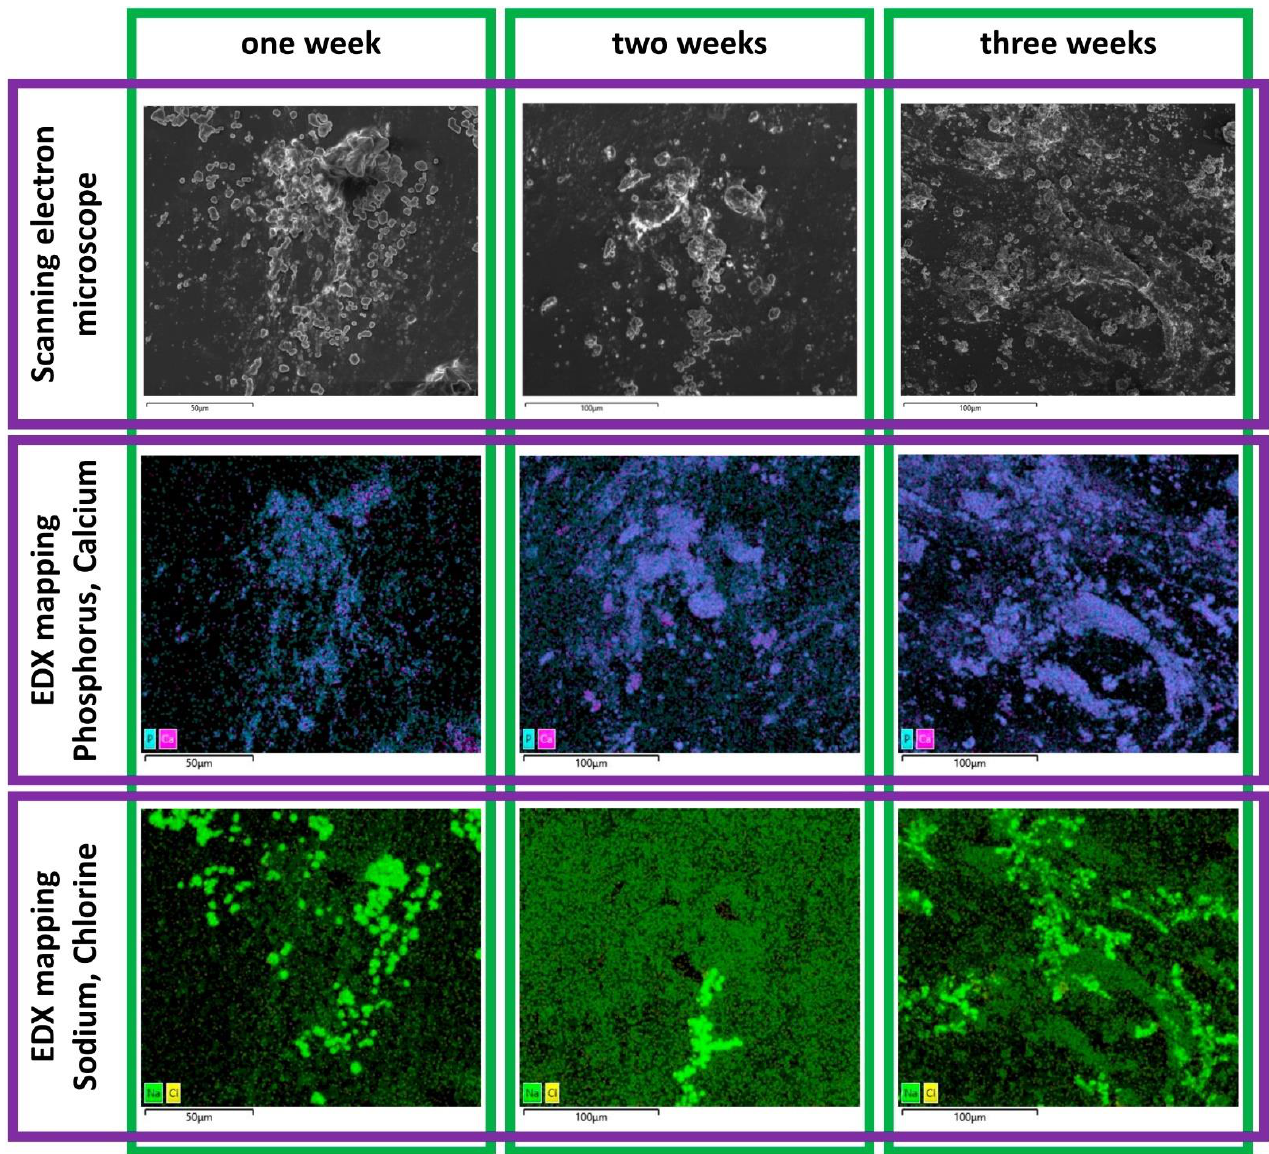
Figure 6. Scanning electron microscopy images of the mineralization study at the different time points and corresponding energy-dispersive X-ray spectroscopy mapping for Na, Cl and Ca,